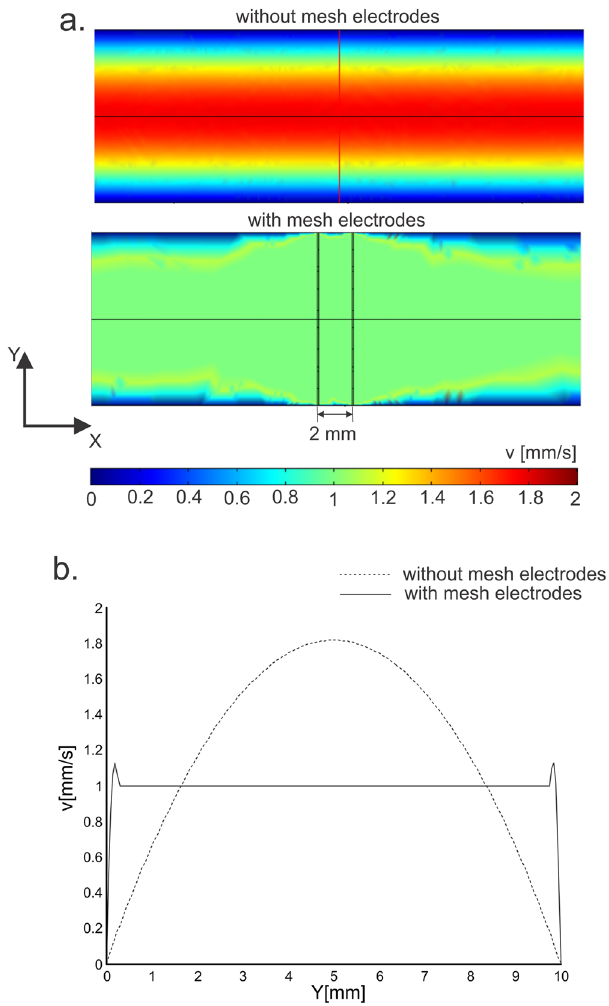
Figure 6. Calculated fluid flow velocity profiles within the treatment chamber without mesh electrodes and with mesh electrodes ( a ) v(X,Y) displayed in XY central cross section of the 3D model and ( b ) v(Y) along Y